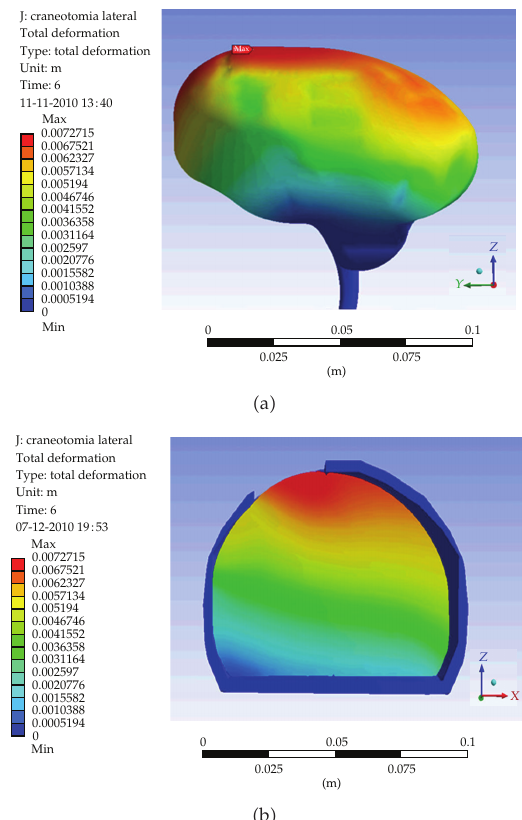
Figure 11: Brain displacement for parietal craniotomy, hyperelastic second-order Ogden model.